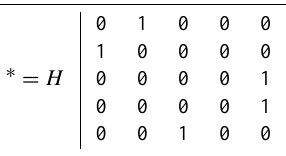
Table 15. The options scoring.